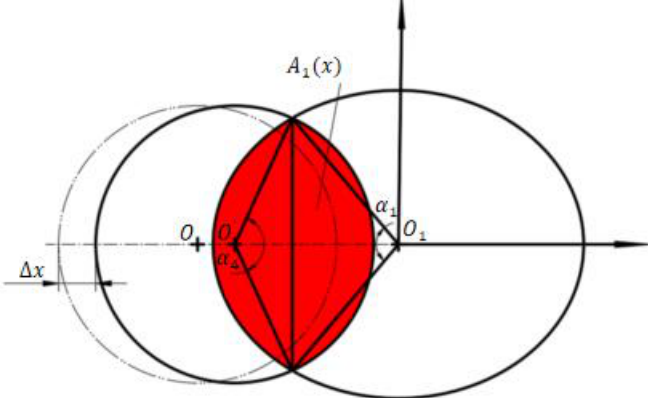
Figure 3. Projection relationship between the hole and the upper surface of the receiver.